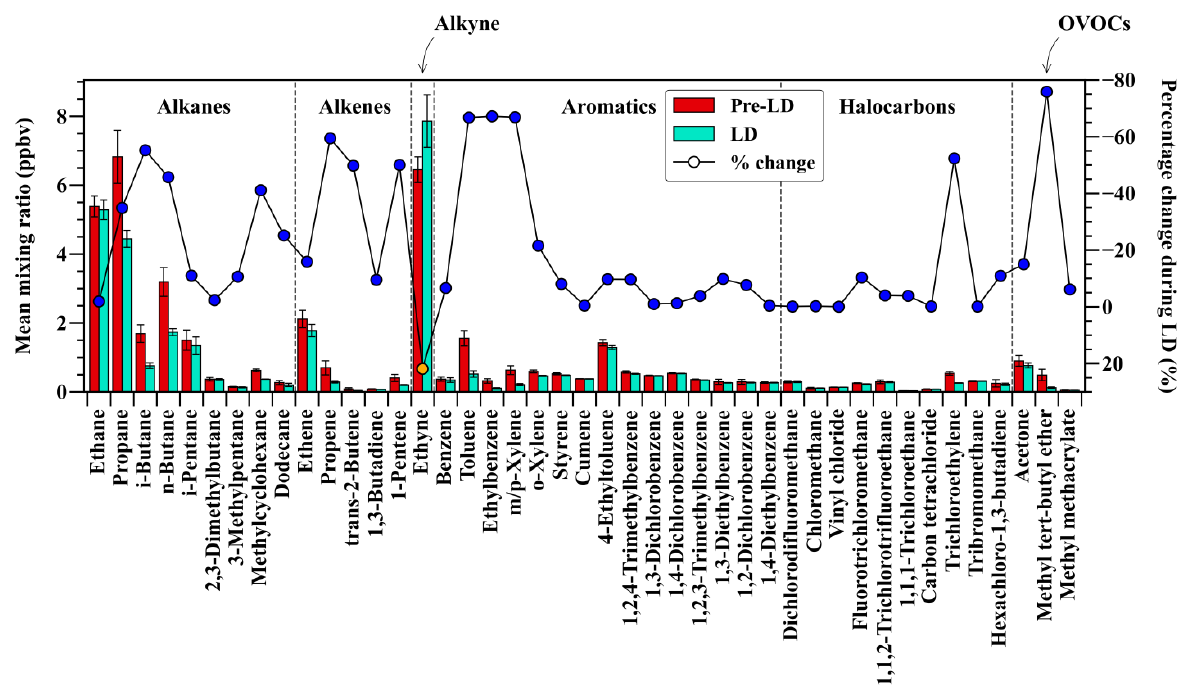
Figure 3. Average mixing ratios of individual VOCs during Pre-LD (red bar) and LD (green bar), and their percentage changes (blue circle: reduction; orange circle: increase). Error bars represent 95% confidence intervals. The changes and p -values are listed in Table S4.